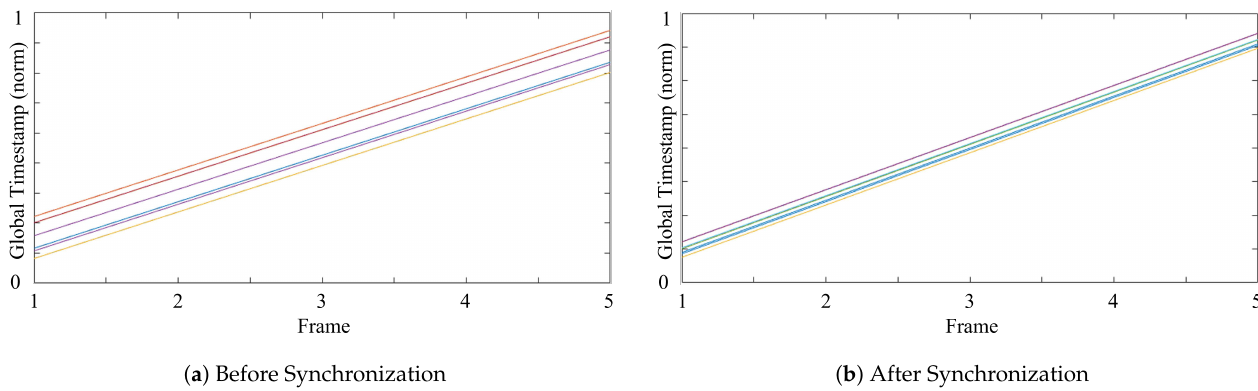
Figure 8. Global timestamps from the 18 RealSense cameras ( a ) without and ( b ) with the proposed synchronization